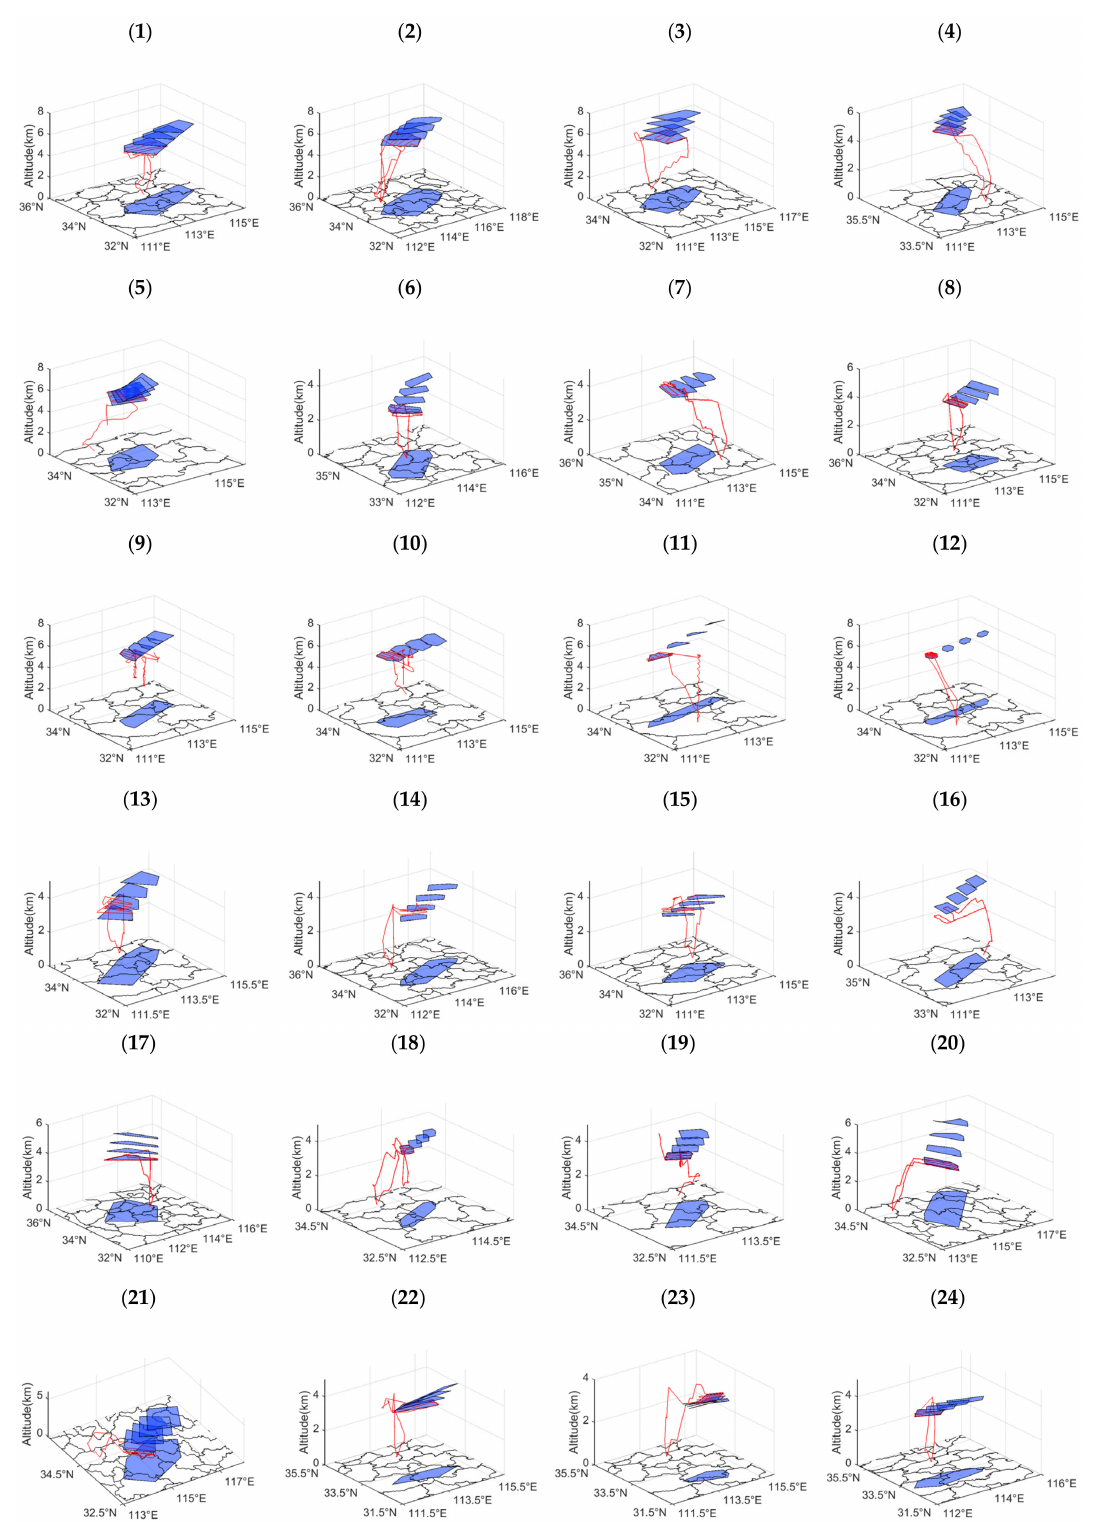
Figure 5. Three-dimensional geospatial configuration of the airline and the hourly affected area within 3 h after seeding for 24 aircraft precipitation enhancement operations ( 1 – 24 ). Note: The solid red line is the airline path, the blue area in the sky is the influence area, the blue area on the ground is the projection of the influence area in the